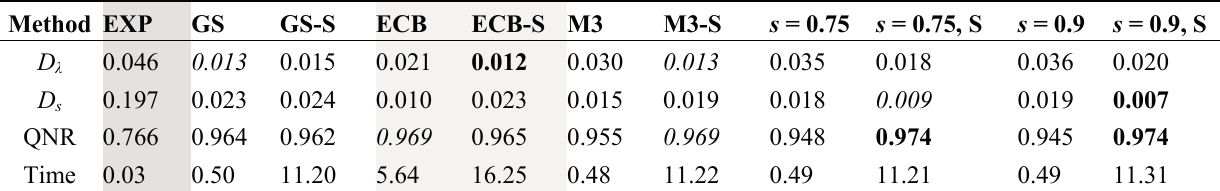
Table 8. Quantitative comparison of the fusion results to check Alparone’s protocol for the WorldView-2 group 1 dataset at full scale, i.e ., at 0.5 m. Time is measured in minutes. The font face indicators are identical to those in Table 2.